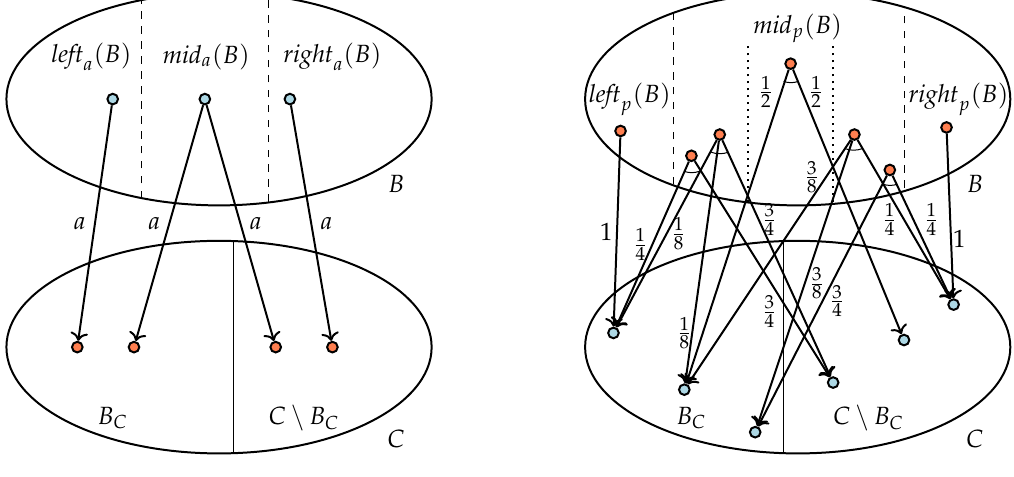
Figure 2. Splitting a non-stable block B into left , middle and right